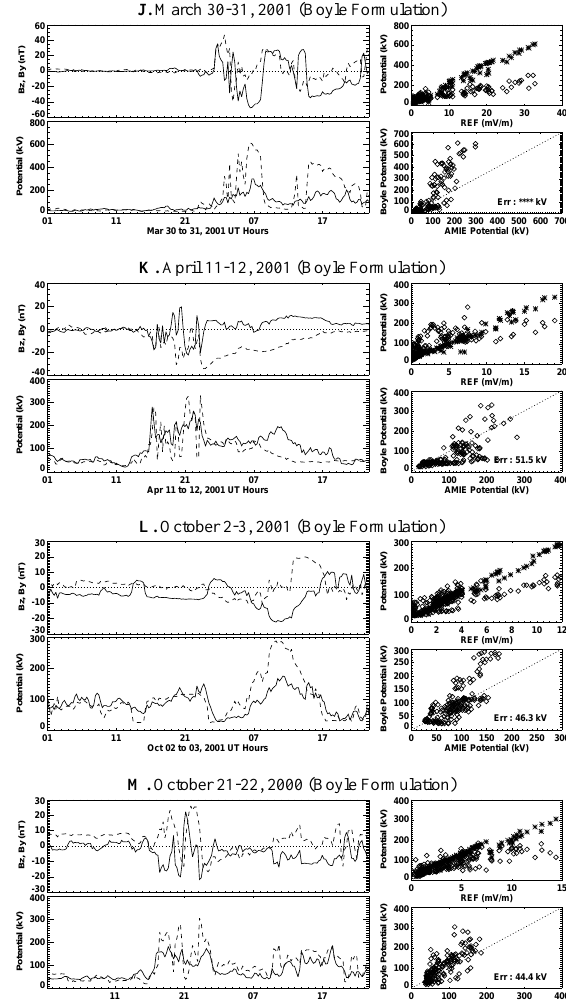
Fig. 4. Four more events in the same format as Figure 1.